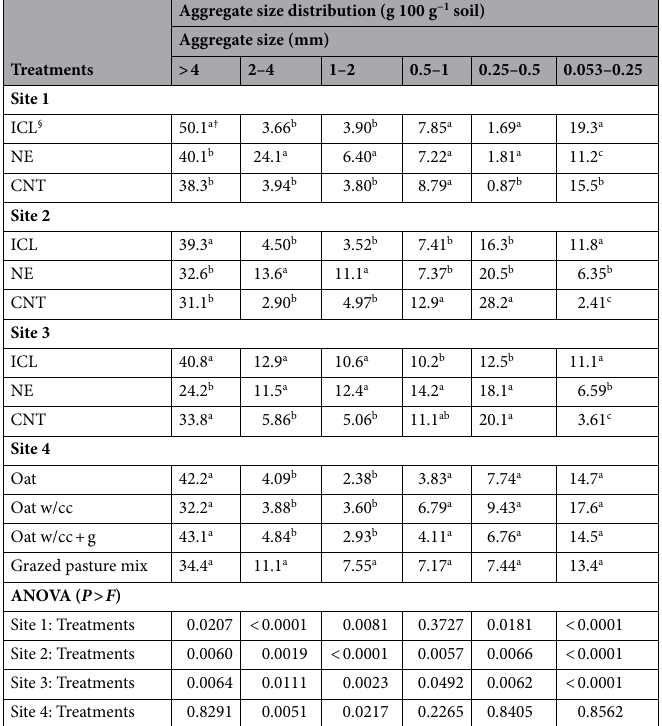
Table 1. Aggregate size distribution at 0–5 cm soil depth under different production systems at four different sites. § ICL integrated crop–livestock, NE natural ecosystem, CNT control, CC cover crop, g grazing. † Means followed by different letters within a column under each site are significantly different at P ≤ 0.05 according to Fisher’s